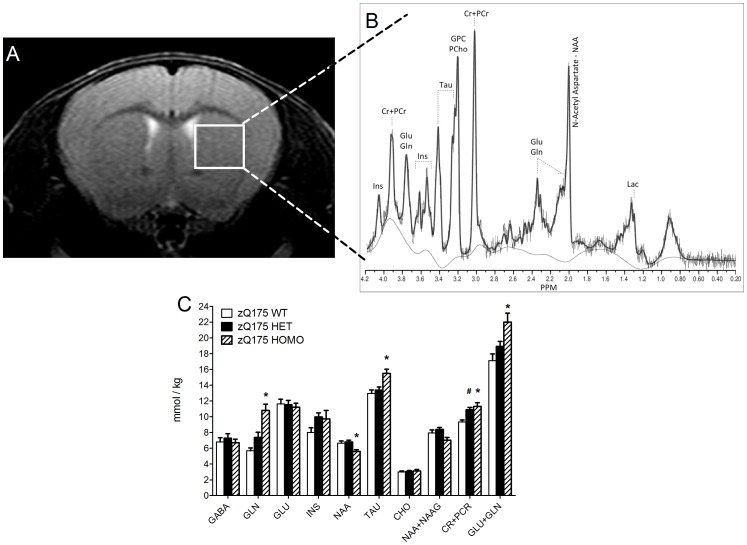

In vivo MRS in the striatum of Q175 and WT mice.(A) Representative T2-weighted MRI and localized volume from which the (B) MR spectra were recorded. (C) The concentrations of striatal metabolites at 12 months of age as measured by MR spectroscopy. Data are presented as mean SEM. Abbreviations: GABA, gamma-aminobutyric acid; GLN, glutamine; GLU, glutamate; INS, myo-inositol; NAA, N-acetylaspartate; TAU, taurine; CHO, choline; NAA+NAAG, N-acetylaspartate+N-acetylaspartylglutamate; CR+PCR, creatine+phosphocreatine; GLU+GLN, glutamate+glutamine. Data are presented as mean ± SEM. * p<0.05 zQ175 HOMO mice vs. zQ175 WT mice; # p<0.05 zQ175 HET mice vs. zQ175 WT mice (zQ175 WT, n = 10; zQ175 HET, n = 10; zQ175 HOMO, n = 9).